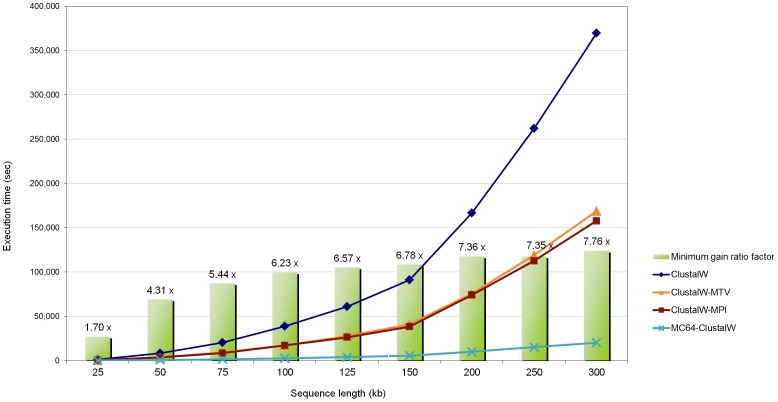
Execution time of the alignment of sets of ten randomly-generated sequences of different sizes, using Clustal W implementations.The tested algorithms are the original Clustal W 1.83, the MC64-ClustalWP2 for Tile64 and PC, and two parallel implementations for x86 systems (MT-ClustalW and ClustalW-MPI). In addition, the minimum gain ratio of the MC64-ClustalWP2 against all the other implementations is exposed for each set of sequences.